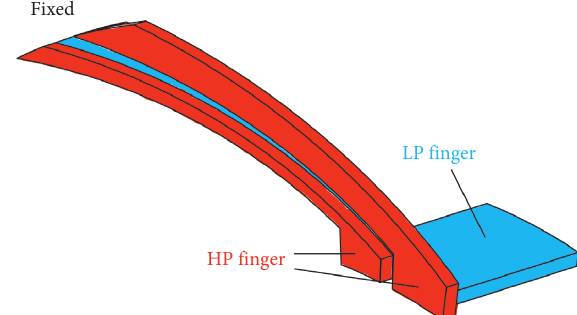
Figure 2: Basic unit of the noncontacting finger seal.